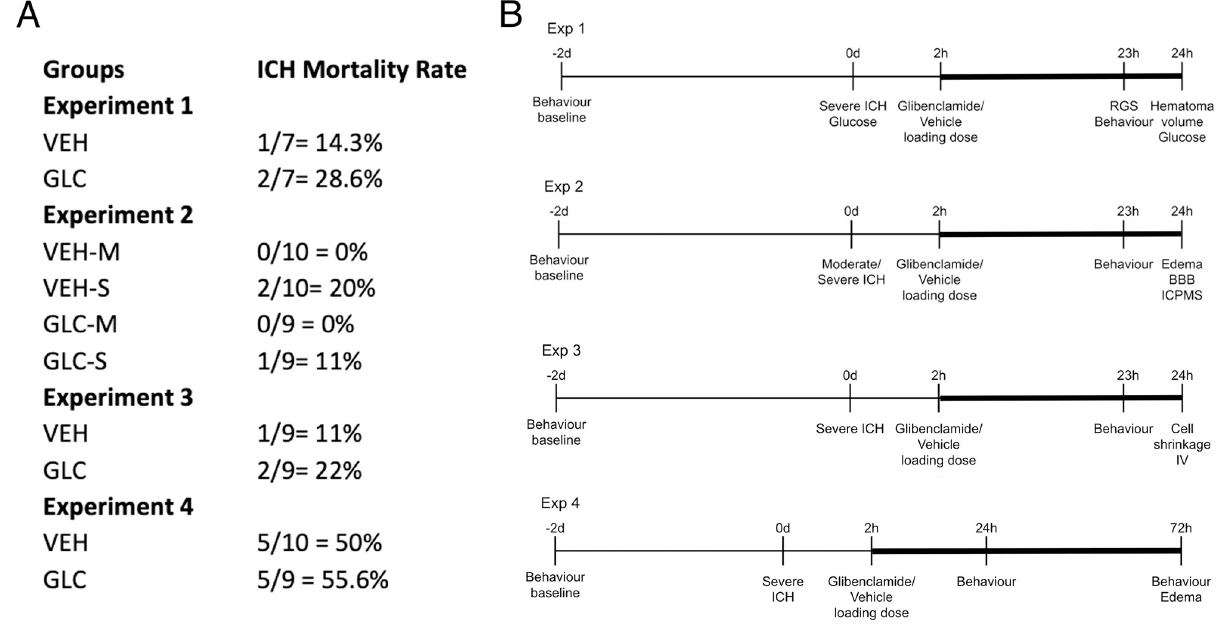
Fig 1. Mortalities and timelines. Mortality rates per experiment for vehicle-treated (VEH) and glibenclamide-treated (GLC) groups (A). Experimental timelines are also shown (B). The continuous glibenclamide infusion period is denoted by thick bars. Mortality rates for severe strokes were not significantly different across groups (p = 0.6783). There were no mortalities for the moderate stroke group. Exclusions for each experiment are listed in the Results section. RGS, hematoma volume and blood glucose were assessed in experiment 1. Edema, BBB integrity, and element concentrations (via inductively coupled mass spectrometry (ICPMS)) were assessed in experiment 2. Cell volume and density along with injury volume assessments were performed in experiment 3. Edema was assessed in experiment 4. Behaviour, as assessed by the NDS and forelimb placing, was performed for all experiments at 24 hours (experiments 1–3) and 72 hours (experiment 4). All rats had a behavioural baseline taken 2 days prior to ICH, and drug infusion began 2 hours post-ICH induction. Rats were euthanized at 24 hours (experiments 1–3) or 72 hours (experiment 4).